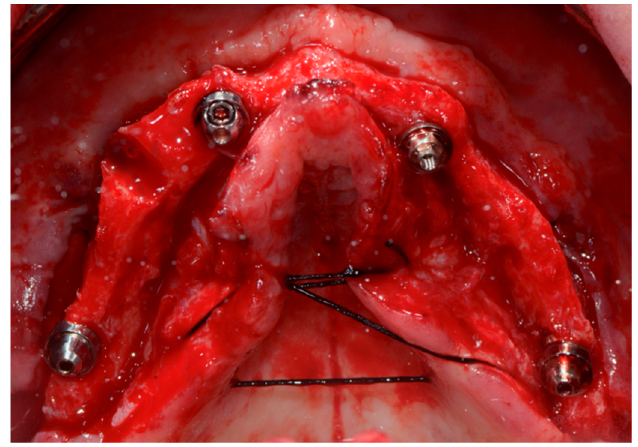
Figure 2. Open flap surgery for implant positioning (traditional protocol). Table 1. Implants’ diameters (D) and lengths (L).